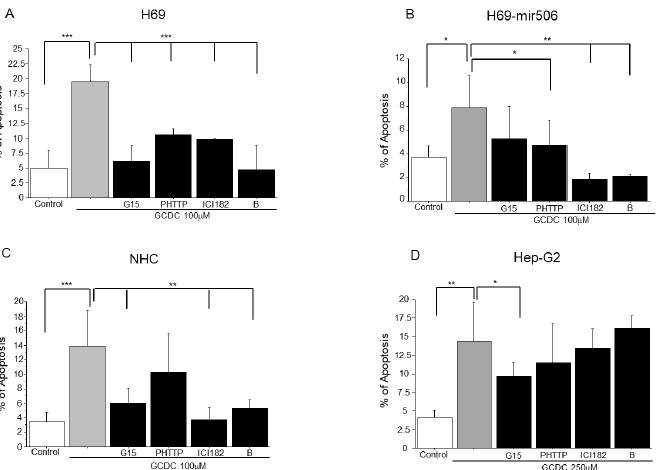
Figure 2. Effect of DHEA and its metabolites on the apoptosis induced by GCDC in cholangiocytes and hepatocytes. H69 ( A , B ), H69-mir506 ( C ), NHC ( D ) and Hep-G2 ( E ) cells were incubated with DHEA or its metabolites followed by GCDC. Twenty-four hours following treatment apoptosis was detected using an Annexin V/Propidium iodide (PI) kit. X-axis, Annexin V. Y-axis, PI fluorescence intensities. Representative figures show the population of viable (LL), early apoptotic (LR), late apoptotic (UR) and necrotic (UL) cells. Results are expressed as a percentage of early apoptotic cells from three separate experiments. * Statistically significant difference in comparison to cells treated with GCDC (* p < 0.05).